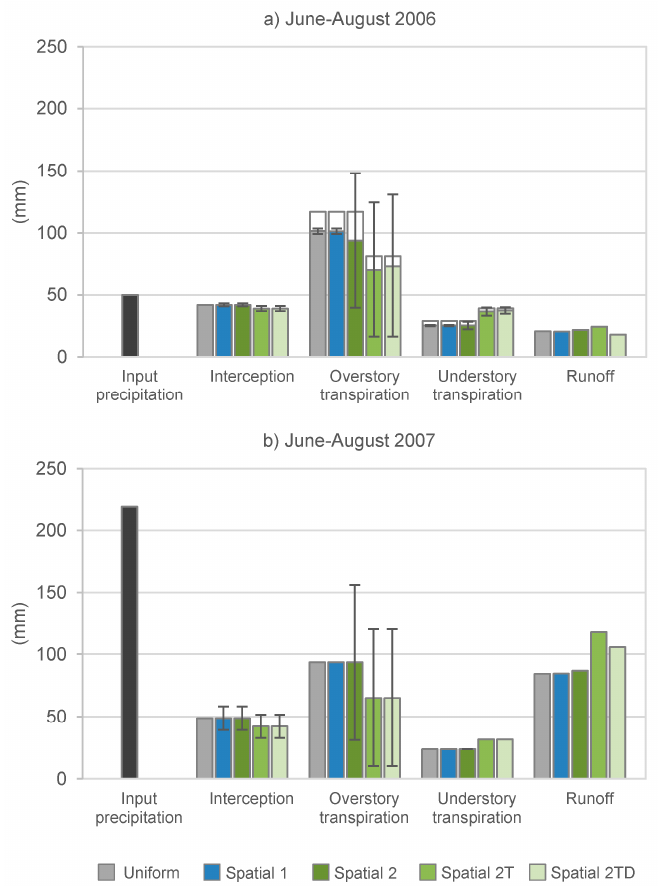
Figure 4. Modeled average water balance in Sattasuo for June–August 2006 ( a ) and 2007 ( b ) with different model scenarios ( Uniform , Spatial 1 , Spatial 2 , Spatial 2T , and Spatial 2TD ). Error bars represent standard deviation over the modeled stand area. The white bars over the overstory and understory transpiration in 2006 represent the share of average potential transpiration that was restricted by the dry conditions in the simulations and thus not realized in the scenarios.